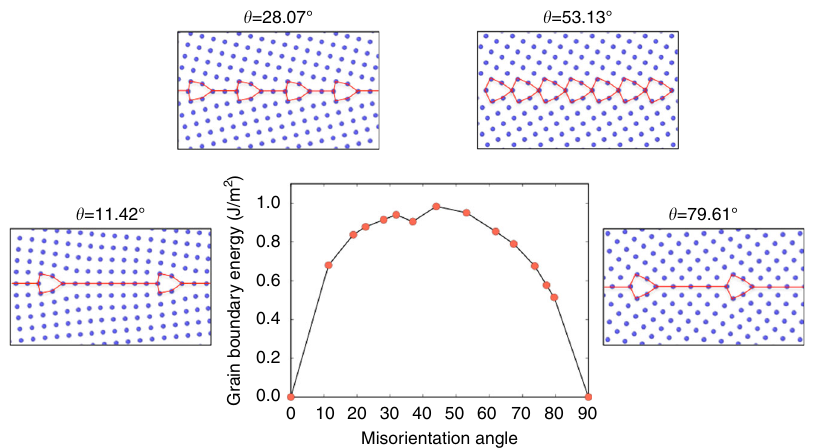
Fig. 1 GB structures predicted by the γ -surface method. The kite family of grain boundary structures predicted by the conventional simulation methodology. Low-energy grain boundary structures of symmetric tilt boundaries in fcc Cu are composed of Kite-shaped structural units. The units separation distance changes with the misorientation angle θ . The construction does not add or remove atoms from the grain boundary core, so not all possible states are sampled. Grain boundary energy of the 13 grain boundaries studied is plotted as a function of misorientation